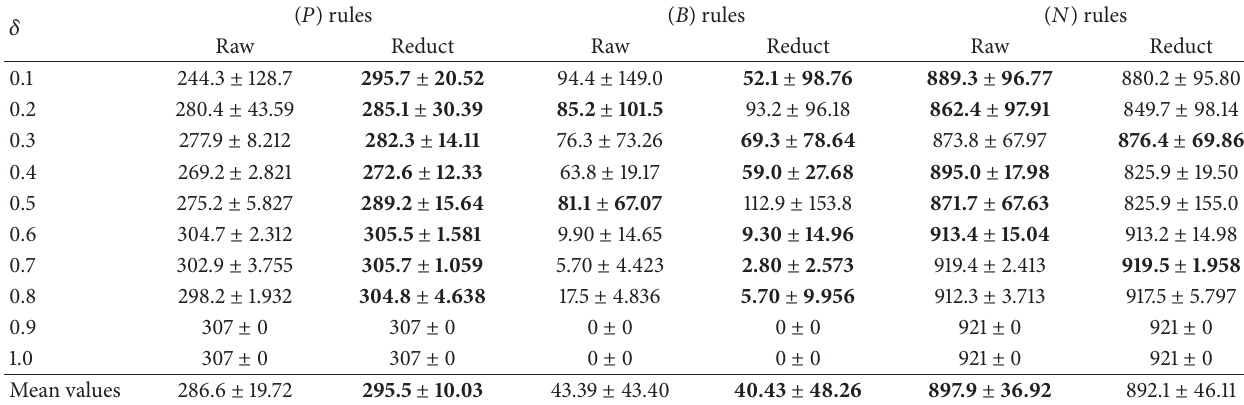
Table 4: The decision rules between raw data and decision-monotonicity criterion based reducts (Soybean).